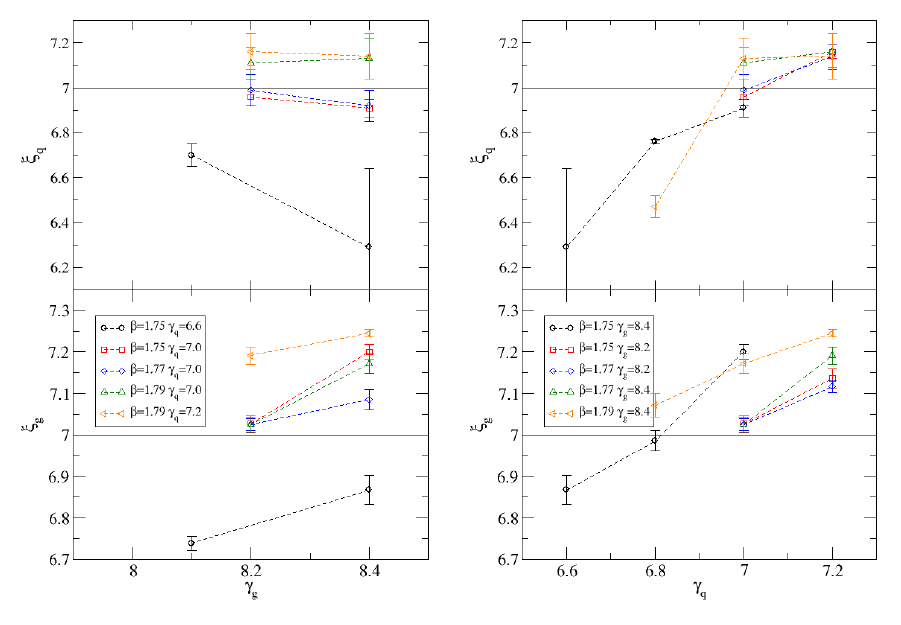
Figure 5. Anisotropy tuning for Gen3, showing how the output anisotropies ξ g, q depend on the input gauge anisotropy γ g (left) and fermion anisotropy γ q (right).